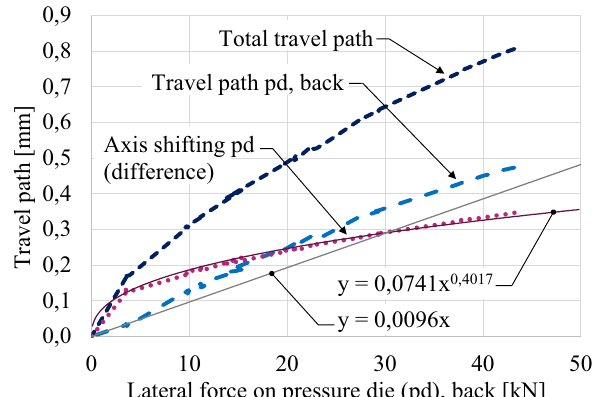
Fig. 15 Axis shifting of the pressure die, back